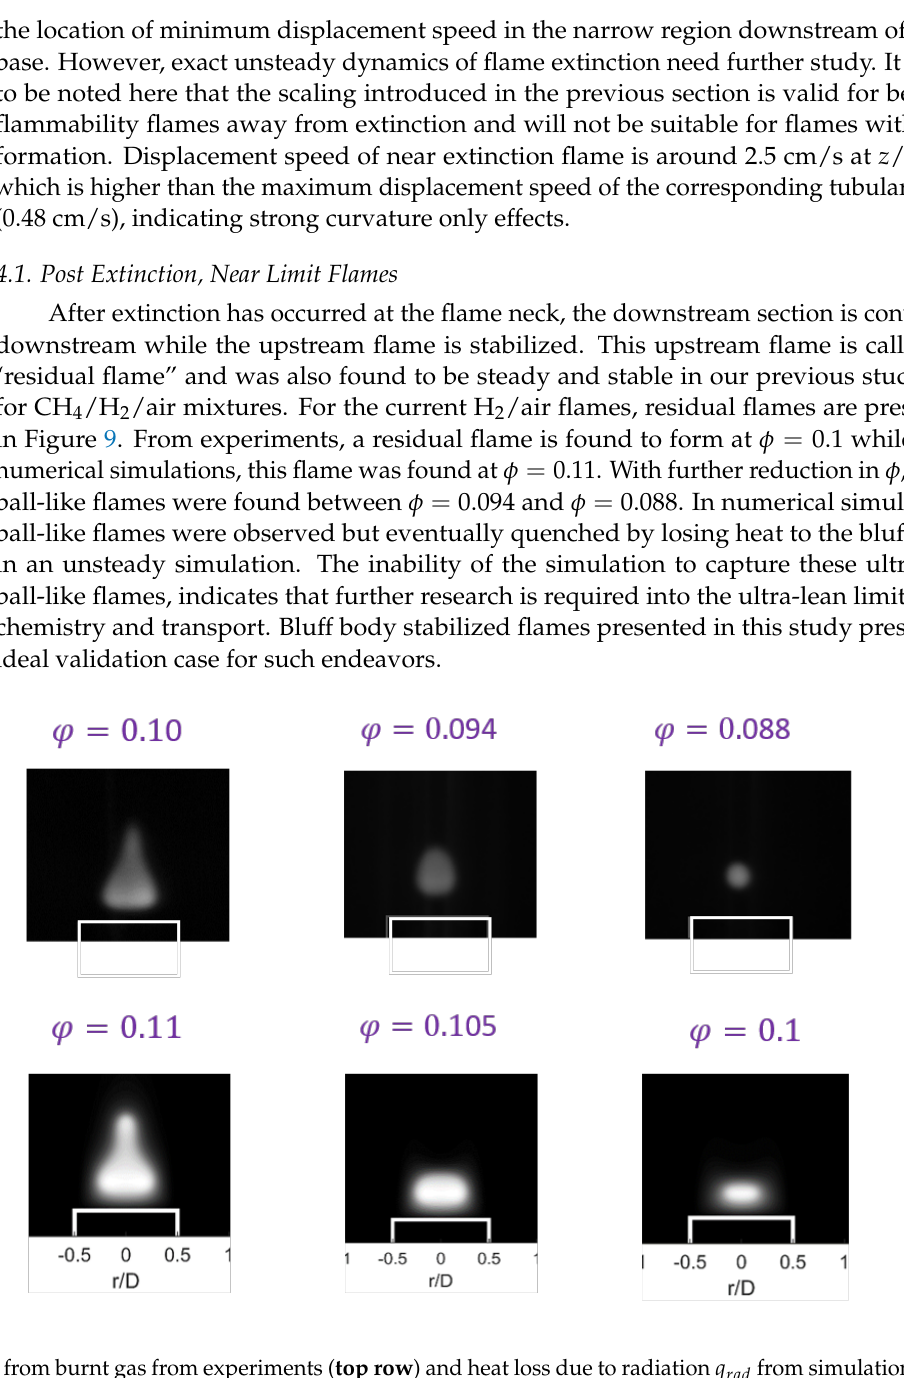
Figure 9. Radiation intensity from burnt gas from experiments ( top row ) and heat loss due to radiation q rad from simulations ( bottom row ) for post-extinction